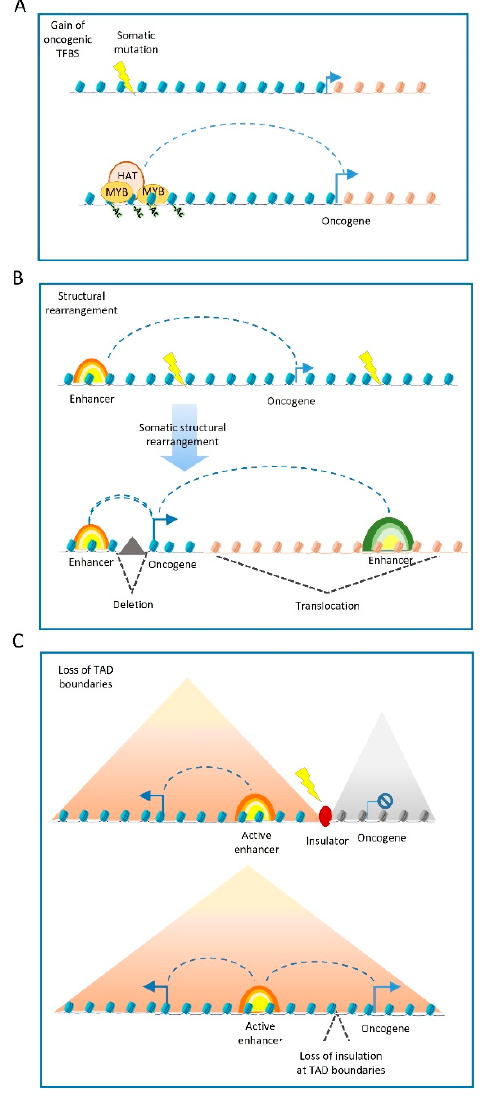
Figure 2. Contribution of mutations that affect enhancer sequence in cancer. ( A ) Somatic mutations can generate novel TF binding sites that recruit epi-modifiers that in turn can deposit epigenetic marks forming putative oncogenic enhancers. ( B ) Structural rearrangement of DNA can increase the expression of oncogenes by assigning ectopic enhancers to oncogenes via chromosomal translocation or by reducing the distance of enhancer to target promoter via deletions. ( C ) Mutations and structural rearrangement can influence the insulator regions and consequently can disturb TAD boundaries that shield oncogenes from nearby enhancers.